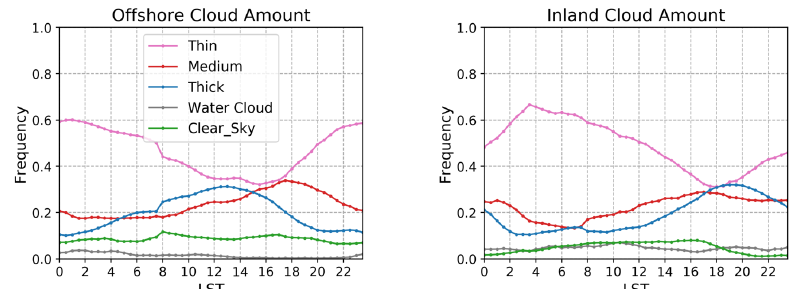
Figure 7. Daily mean evolution in the amount of four cloud types, with averaged values for the offshore and inland areas. The water cloud amount is plotted in gray, whereas ice clouds are decomposed into three cloud types, namely, thin, medium (medium-thick), and thick, according to their cloud optical thickness values. When referring to the rainfall pattern (Figure 3) in which the offshore rainfall peak appeared at 10 LST and the inland rainfall peaked from 17 to 20 LST, the pattern corre- sponded to different cloud stages. For example, in the offshore region, when the rainfall peaked (10 LST), the amount of thick clouds increased, and the amount of thin clouds was much higher than that of thick clouds. For the inland region, when the rainfall peaked (17 to 20 LST), thick clouds also presented a peak amount, which was similar to that of the thin clouds. Therefore, offshore convection appeared to have a larger anvil component, which was mainly composed of thin clouds. Figure 8 shows the spatial distribution of cloud amount for the three ice cloud types, with 3 h as an interval. Thin ice clouds, with ICOT ≤ 3, exhibited a large amount over the offshore SCCA from ~20 to 09 LST and were abundant over the inland region from 03 to ~15 LST, which corresponded to the dissipation/re-establishment stage of convection. Ob- viously, offshore thin clouds appeared more frequently within a continuous area with a large size, whereas inland thin clouds were sparsely distributed over a smaller area.